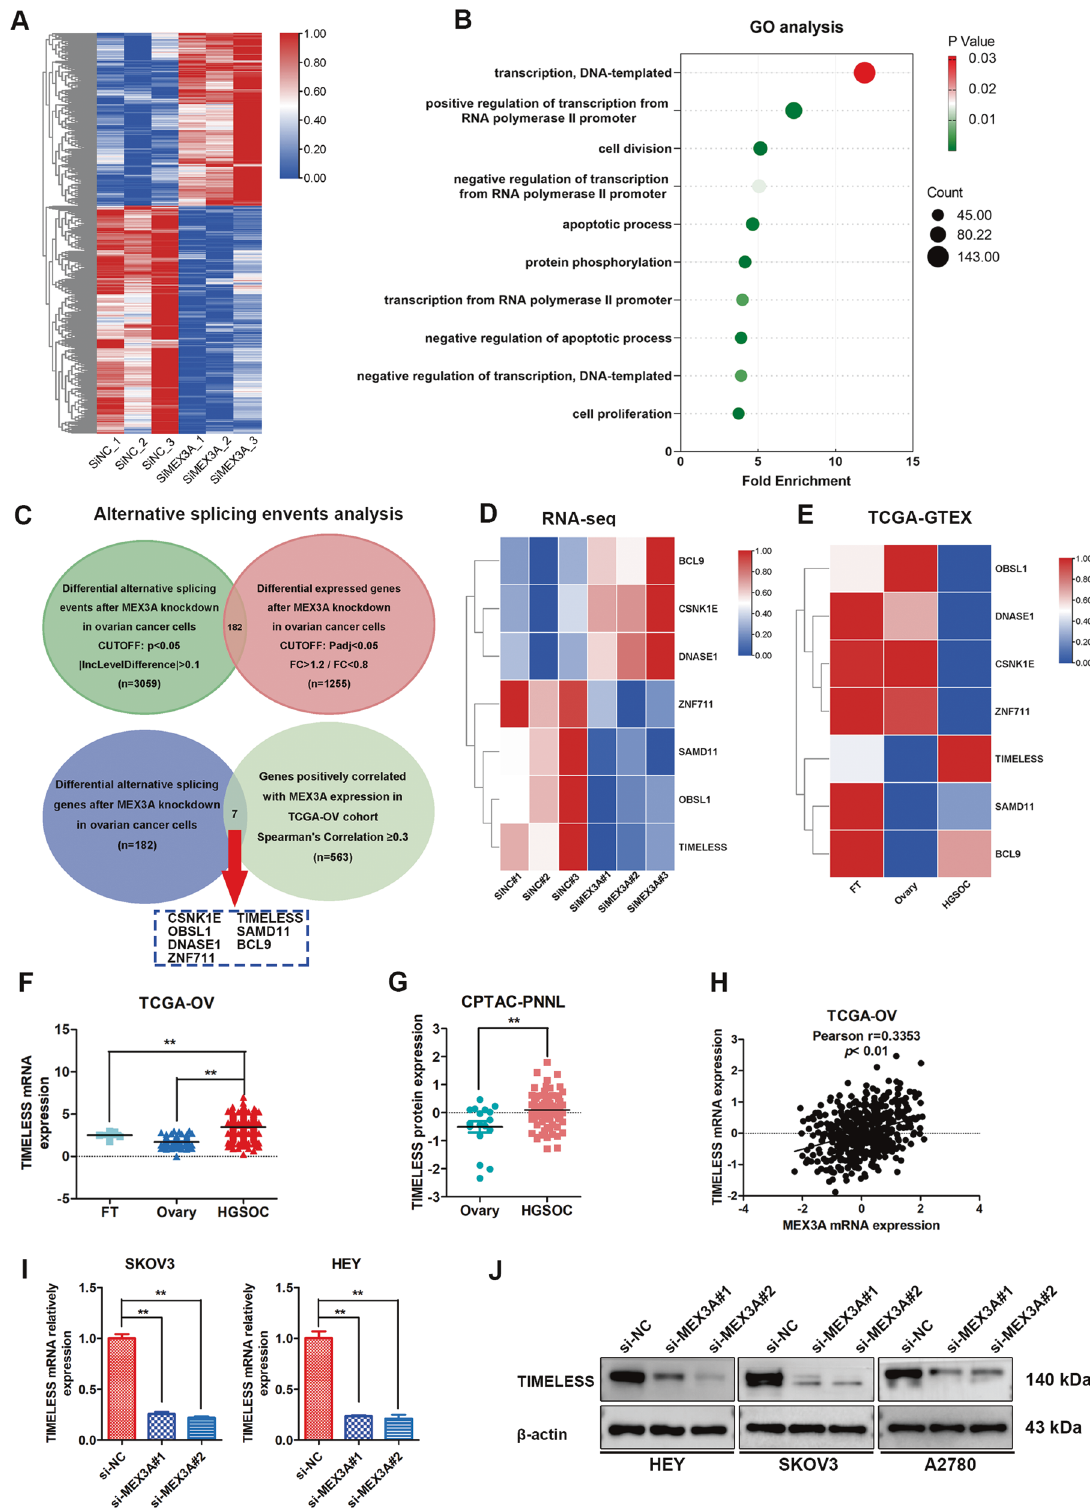
higher than TIMELESS-205 and that TIMELESS-201 expression was the highest in ovarian cancer tissues (Fig. 7D). However, TIMELESS-203 expression was higher than TIMELESS-205 expres- sion, and there was no difference between TIMELESS-201 and TIMELESS-205 expression in ovarian cancer cell lines from the Cell Death and Disease (2022)